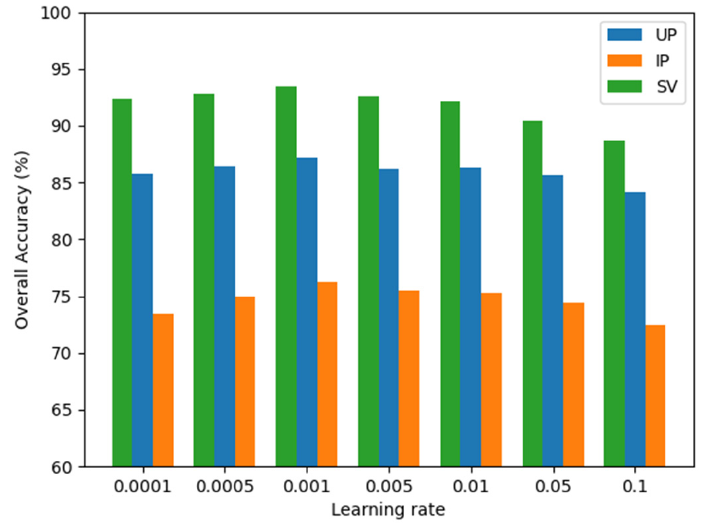
Figure 9. OAs obtained by GDAFSL with different initial learning rates on three target datasets.